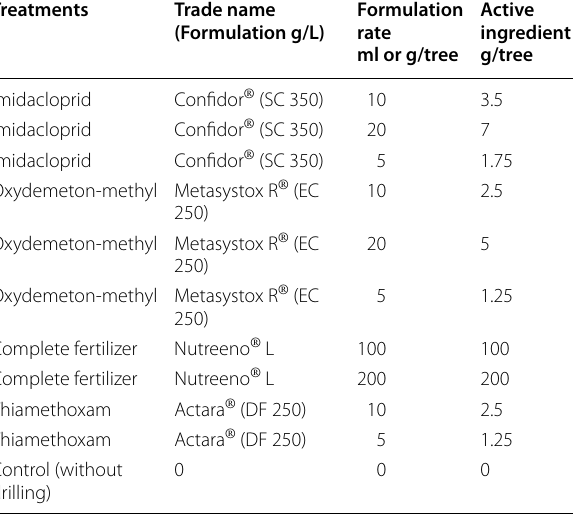
Table 1 List of experimental treatments with three systemic insecticides and a complete fertilizer by optimal injection for infected walnut